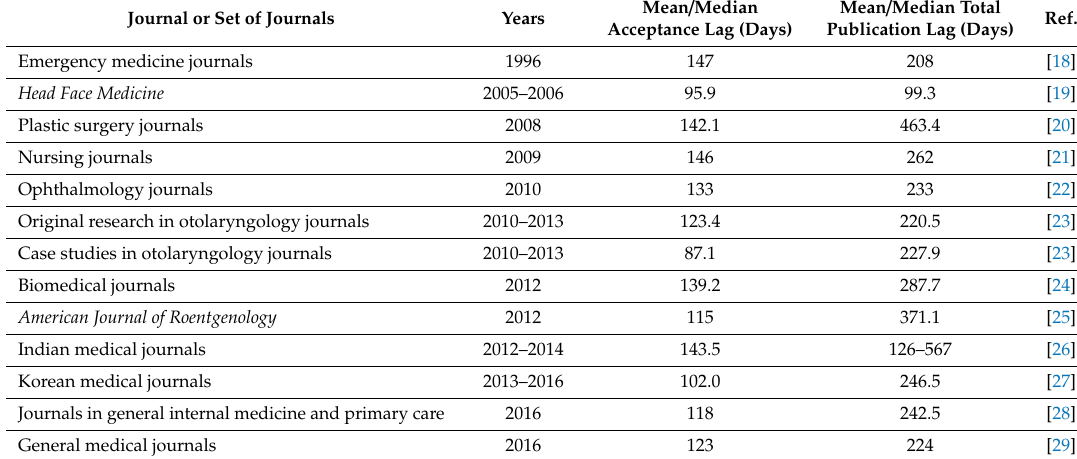
Table 1. Time to acceptance and publication lags for medical journals from the literature. Journal or Set of Journals Years